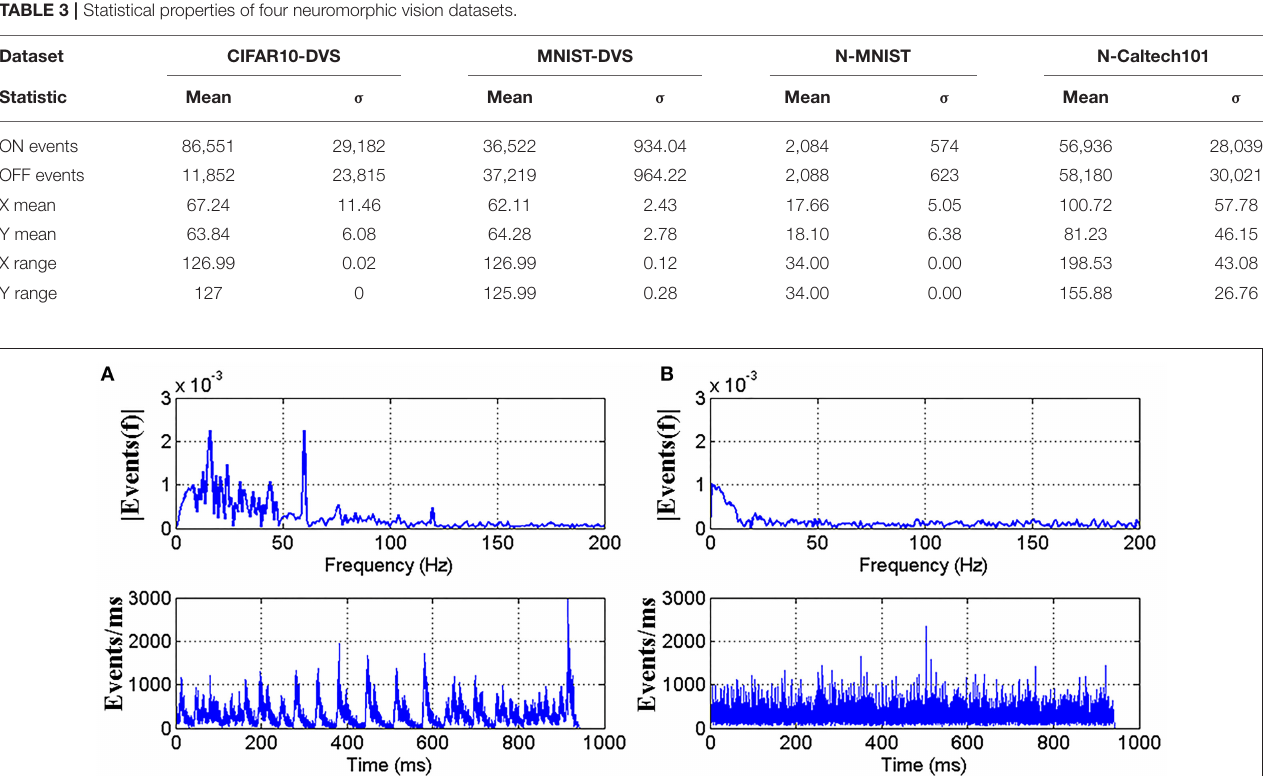
FIGURE 3 | A Fourier analysis showing the impact of LCD screen refresh rate. (A) Top shows the timestamp sequence spectrum of the recorded AER events with a clear peak at 60 Hz. The mean inter-spike difference is 3.20 us and standard deviation is 5.24 us. Bottom shows the firing rate curve of the event stream. (B) Top shows the spectrum of the same recording after readjusting the timestamps to remove the 60 Hz peak. Timestamps are generated randomly with the same mean inter-spike time difference and standard deviation as in (A) .